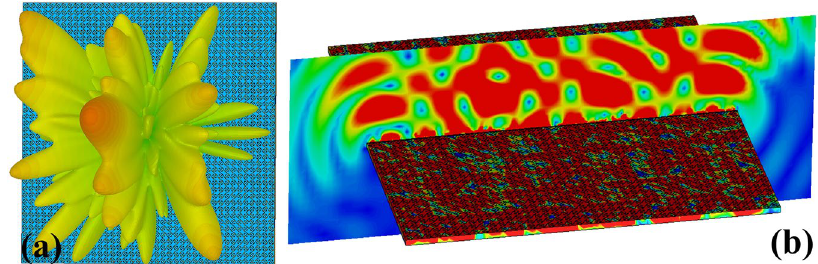
Figure 4. Simulated far-field and near-field pattern of the metasurface under normal incidence at 1 GHz. ( a ) The far-field scattering pattern. ( b ) The surface current distribution and the near-electric-field distributions of the